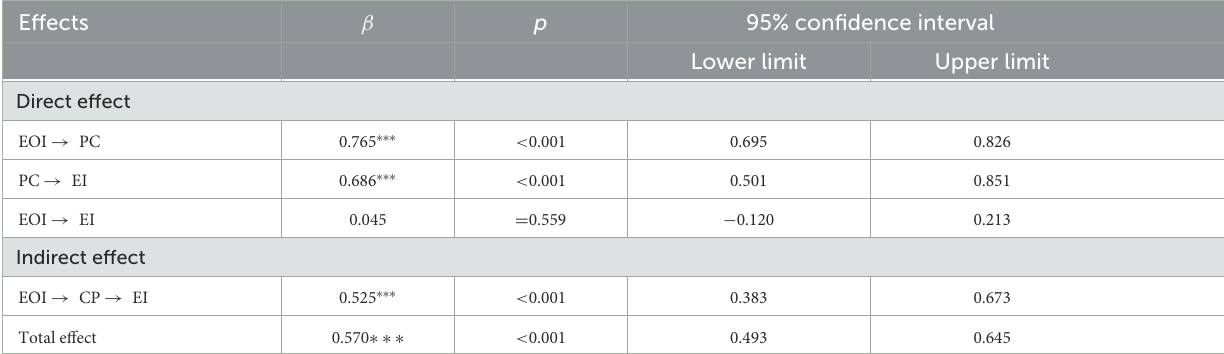
TABLE 7 Bootstrap analyses of a hypothesis mediation